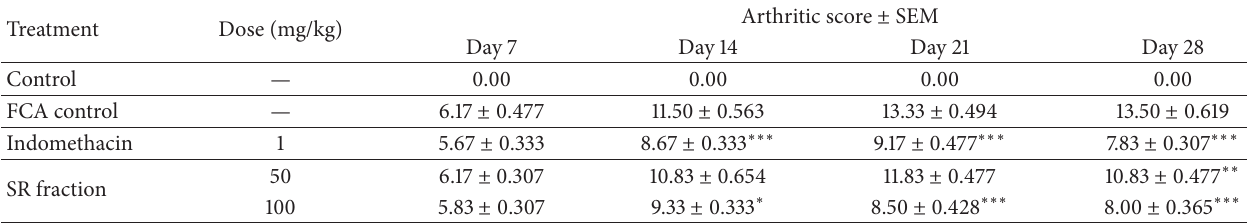
Table 1: Effect of saponin rich (SR) fraction of Achyranthes aspera on arthritis score in arthritic rats. Treatment